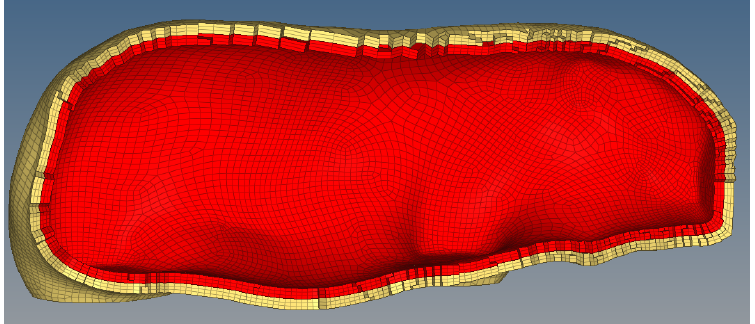
Figure 6. 3D finite element laminated model of external laminated structure.